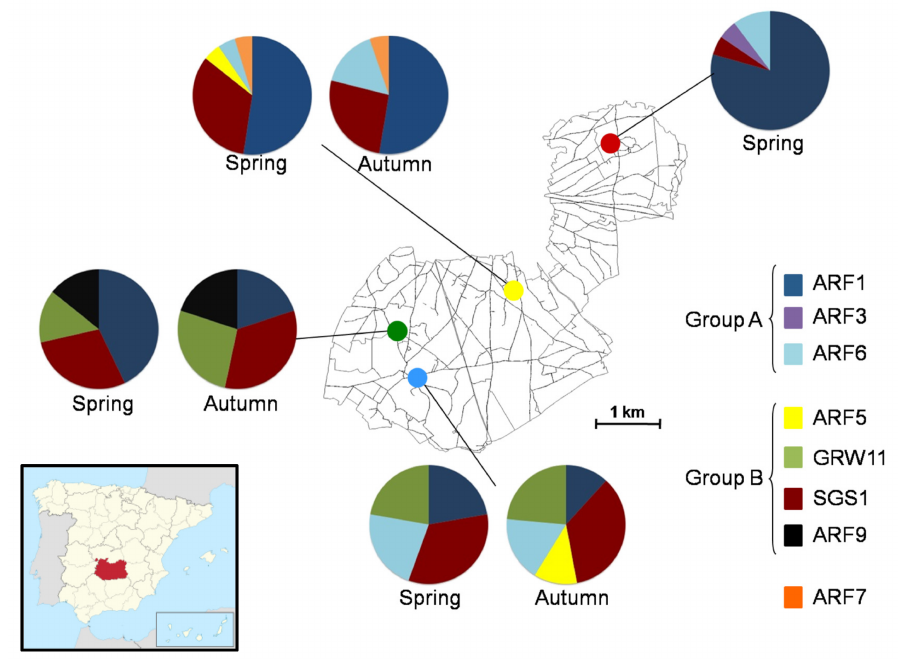
Figure 1. Spatial and temporal distribution of malaria-parasite lineages recorded in four populations of red-legged partridges in Ciudad Real, central Spain (inset shows the location of the Ciudad Real province within the Iberian peninsula). The two main groups of lineages according to Figure 2 are indicated. Pie charts indicate the relative importance of all sequenced Plasmodium infections in a given population. The four host sites are labelled by different colours: yellow—game estate A, blue—game estate B, green—game estate C, and red—game estate D. Percentage values are given in Table